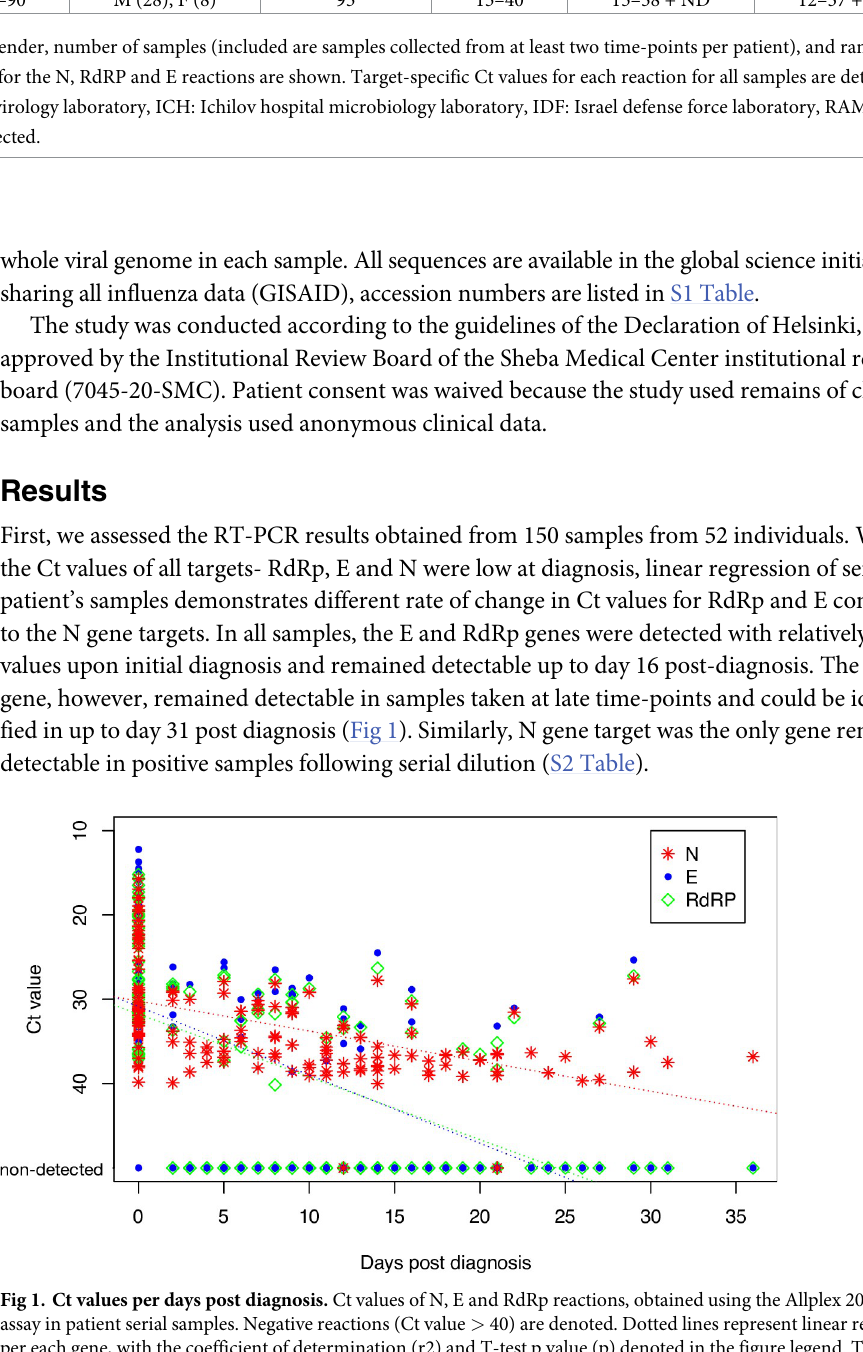
Laboratory of origin, number patients, age range, gender, number of samples (included are samples collected from at least two time-points per patient), and ranges of Ct values obtained using the Allplex-2019 nCov assay for the N, RdRP and E reactions are shown. Target-specific Ct values for each reaction for all samples are detailed in S1 Table. M, Male, F, Female; ICVL: Israel central virology laboratory, ICH: Ichilov hospital microbiology laboratory, IDF: Israel defense force laboratory, RAM: Rambam hospital virology laboratory; ND: not